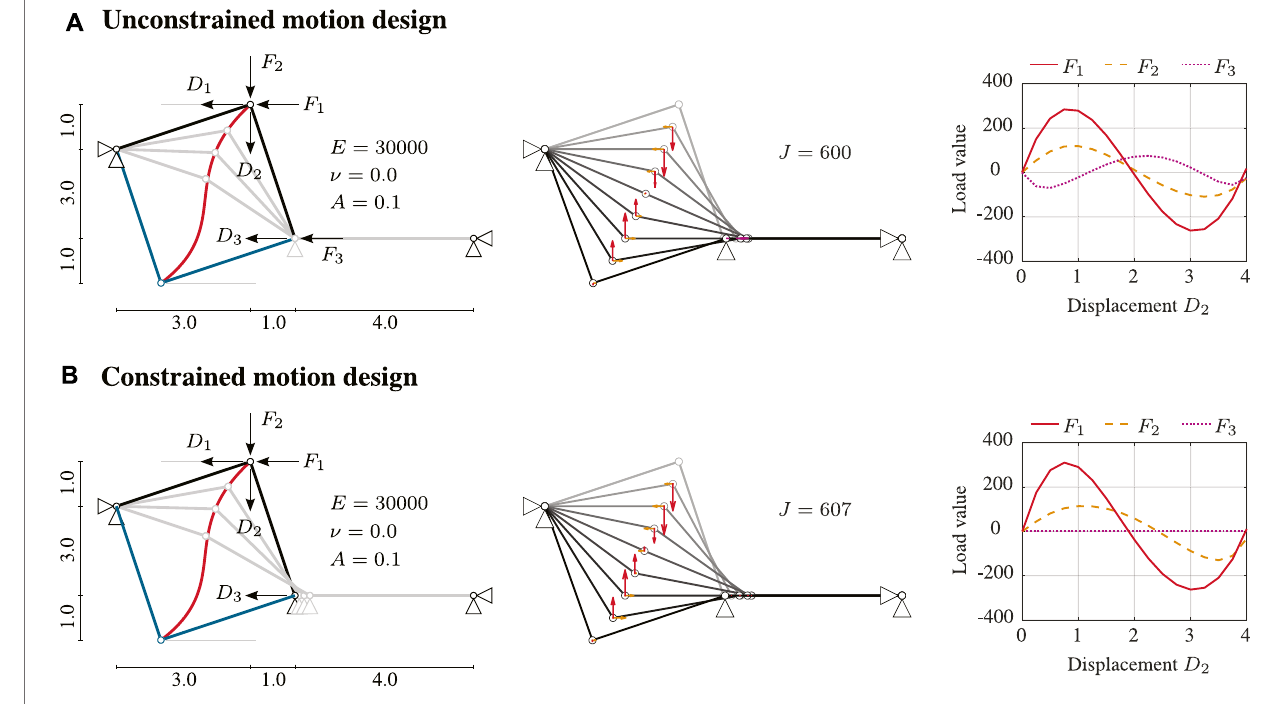
FIGURE 2 | An illustrative example for unconstrained and constrained motion design. (A) Unconstrained motion design and (B) Constrained motion design.